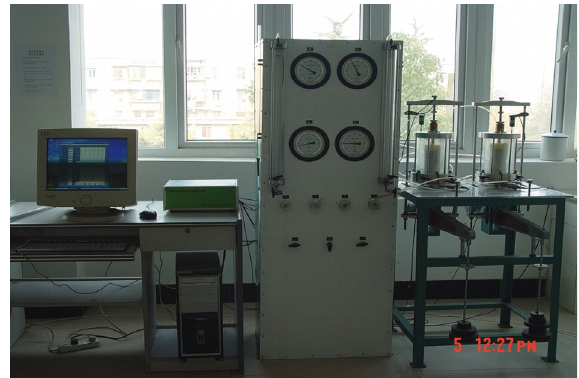
Figure 1: Triaxial rheological